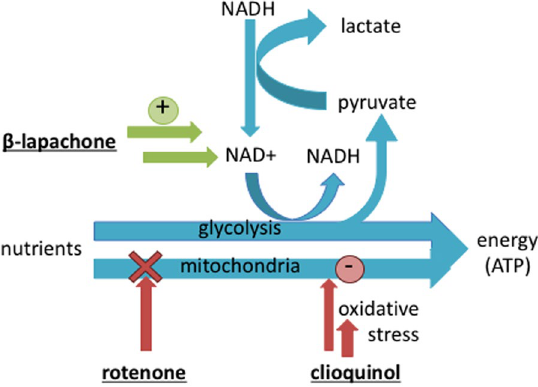
Figure 4. Schematic explanation of lactate production in cells because of the generation of NAD + from NADH to sustain glycolysis. Rotenone is a mitochondrial poison, inhibiting mitochondrial function; cloquinol causes oxidative stress and as a result compromises mitochondrial function and β lapachone results an increase of NAD + , which is believed to reduce the need for lactate production.